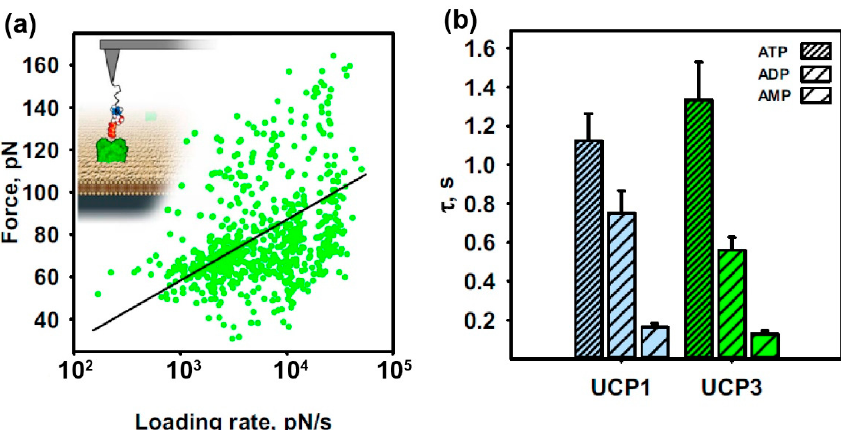
Figure 3. Proof of concept: quantitative characterization of the binding mechanism between UCP1 and its inhibitor ATP (adapted from References [7,10]). Dynamic force spectroscopy to study the binding forces between a pre-selected UCP molecule and its corresponding purine nucleotide (ATP, ADP, AMP). ( a ) Dynamic force spectroscopy plot for the UCP1–ATP interaction. Single-binding events between UCP1 and ATP are shown as green dots. After applying the Bell–Evans model (black line), the bond lifetime can be directly determined. ( b ) Application of this combined mode to other UCP-PN pairs: Dependence of bond lifetimes on PN-phosphorylation for UCP1-PN (blue) and UCP3-PN (green). Shown are the mean values ± SD of at least independent measurements, arising from the fit in ( a ).